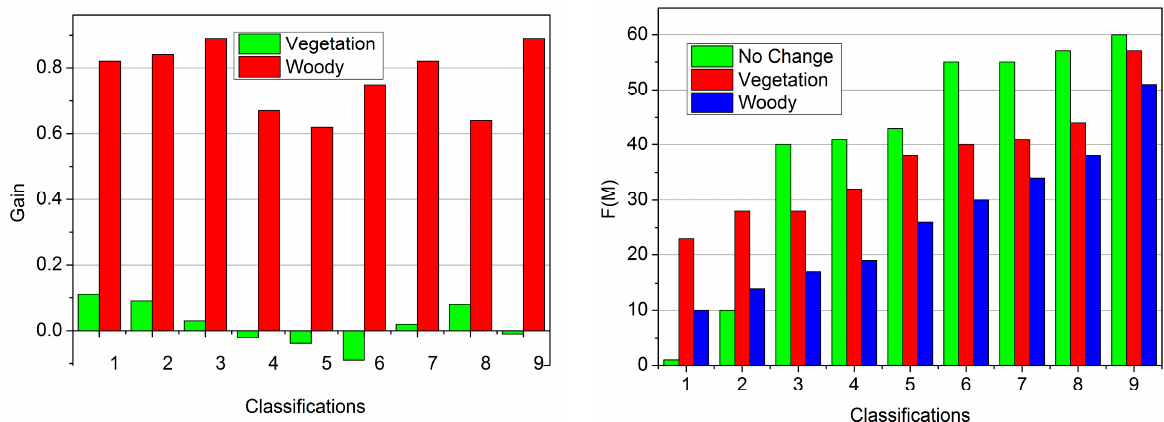
Figure 9. Gain and 𝐹(𝑀) analysis Figure 9. Gain and F ( M ) analysis.